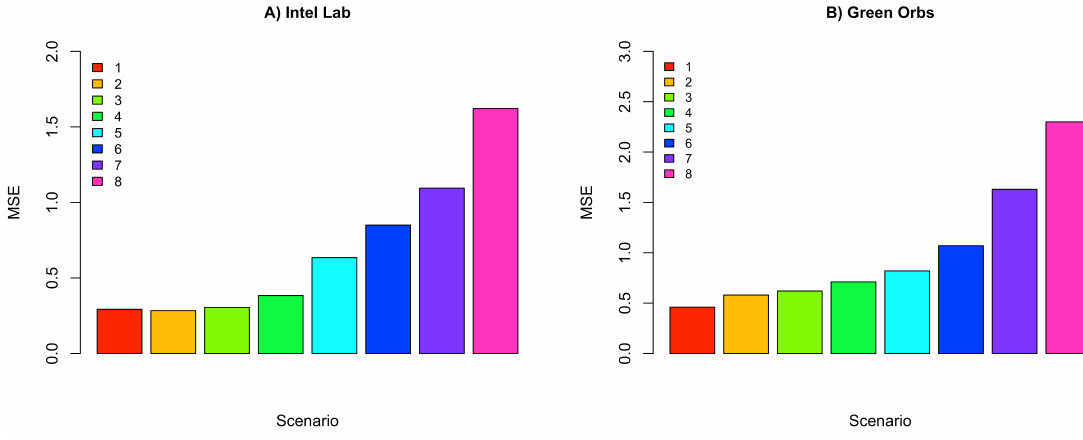
Figure 12. MSE of ACxSIMv2 for Intel Lab and Green Orbs Dataset.